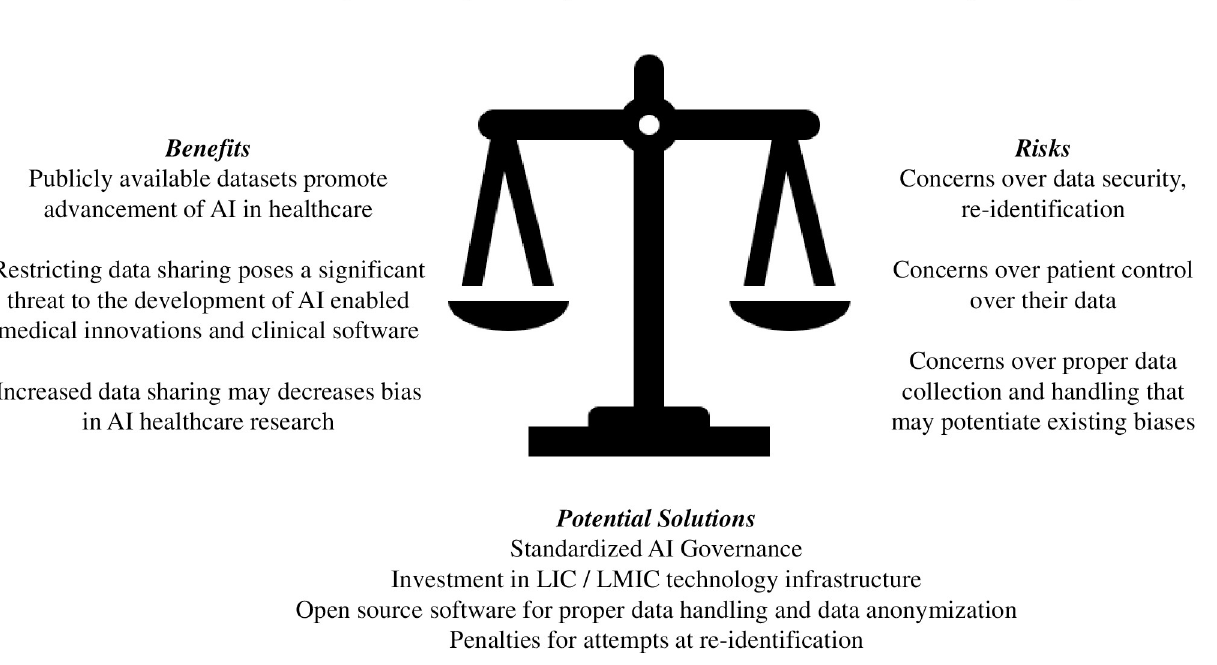
PLOS Digital Health | https://doi.org/10.1371/journal.pdig.0000102 October 6,